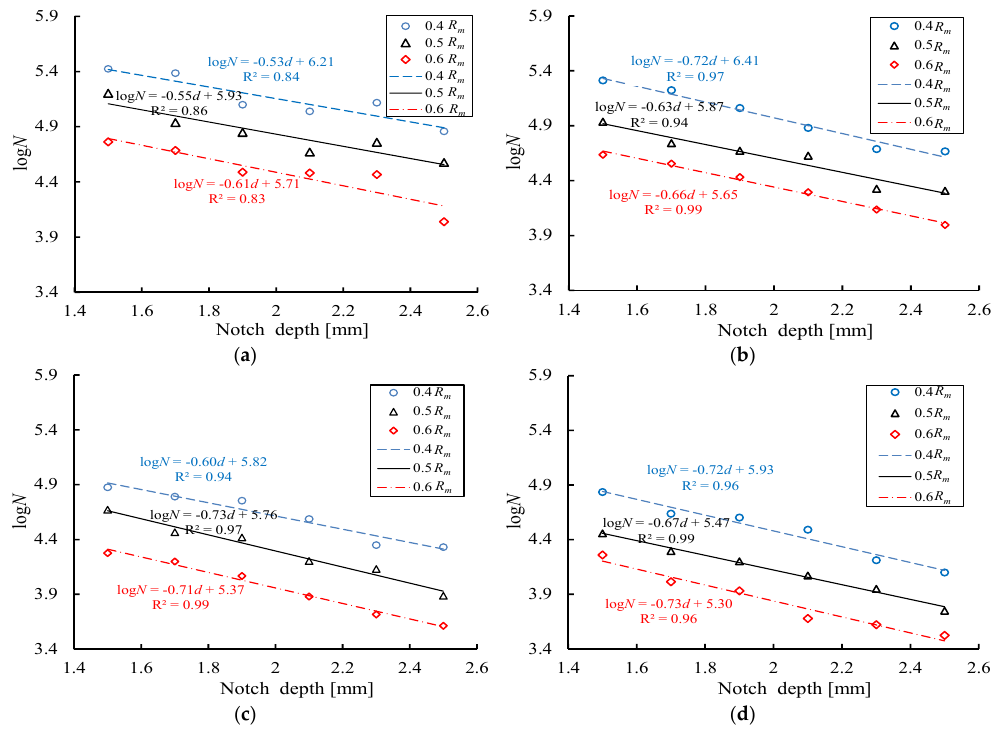
Figure 7. Comparison between the fatigue life of different notched steel bars. ( a ) Axial ellipse; ( b ) radial ellipse; ( c ) length-variable triangle; ( d ) triangle.